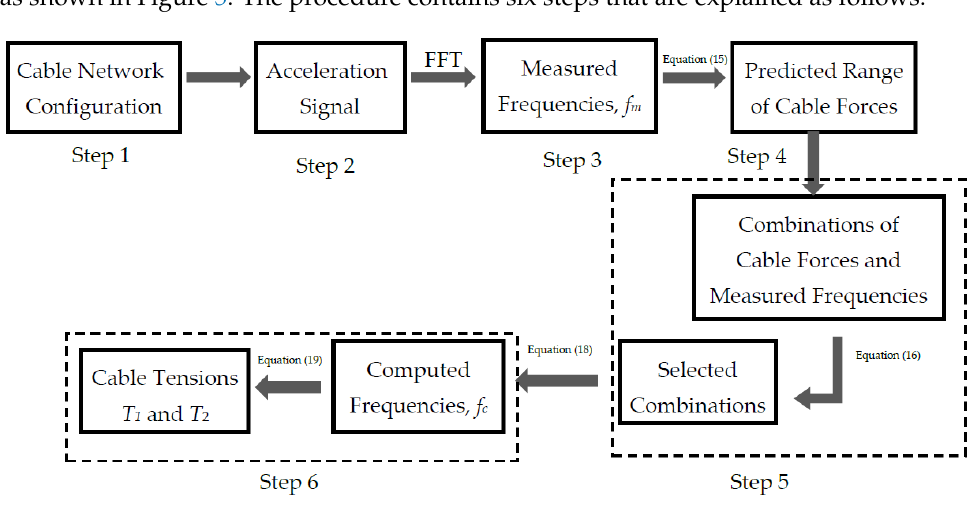
Figure 5. The cable force identification procedure by using measured vibration data.